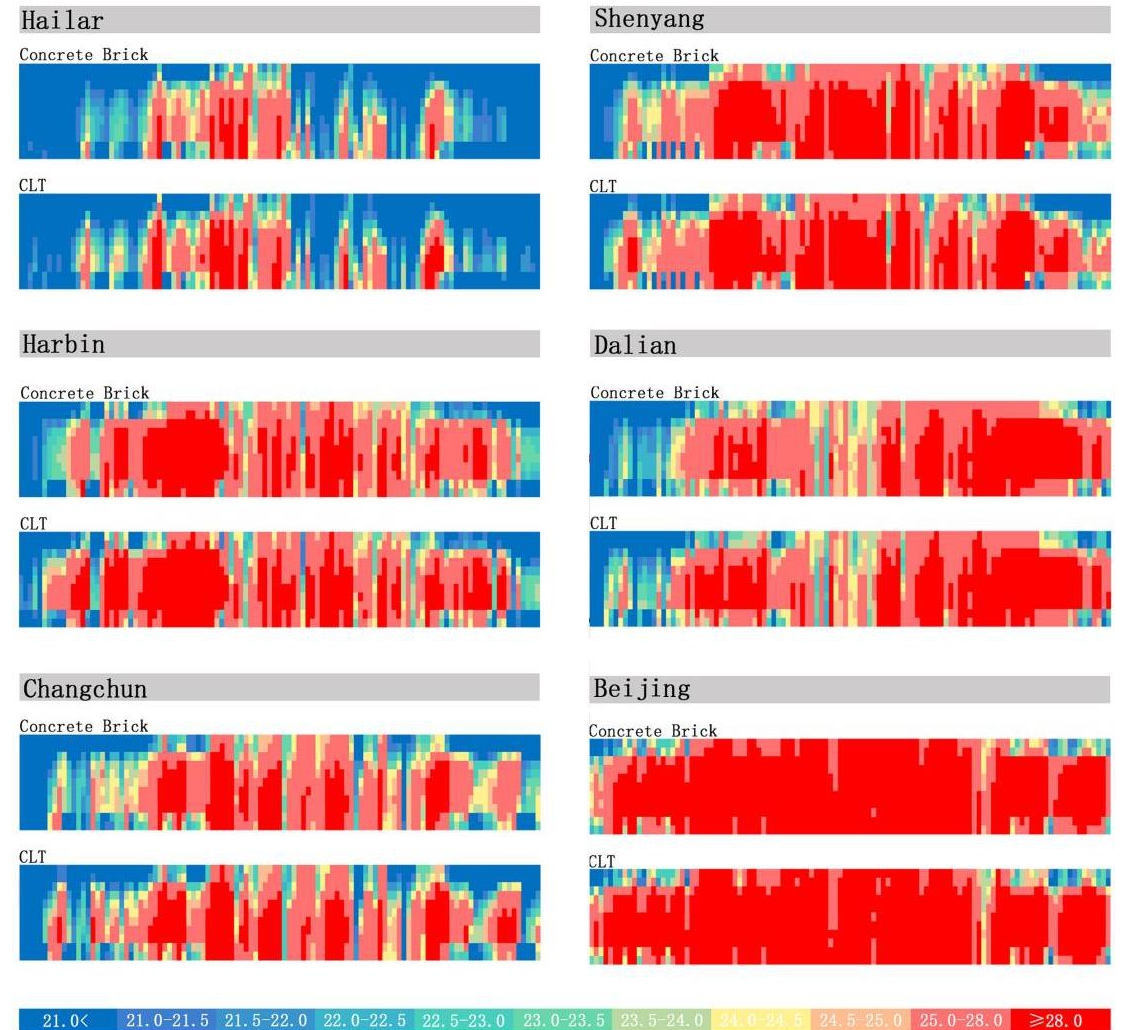
Figure 9. Operative temperature (°C) in the south room at 7F in six cities for concrete and CLT construction.